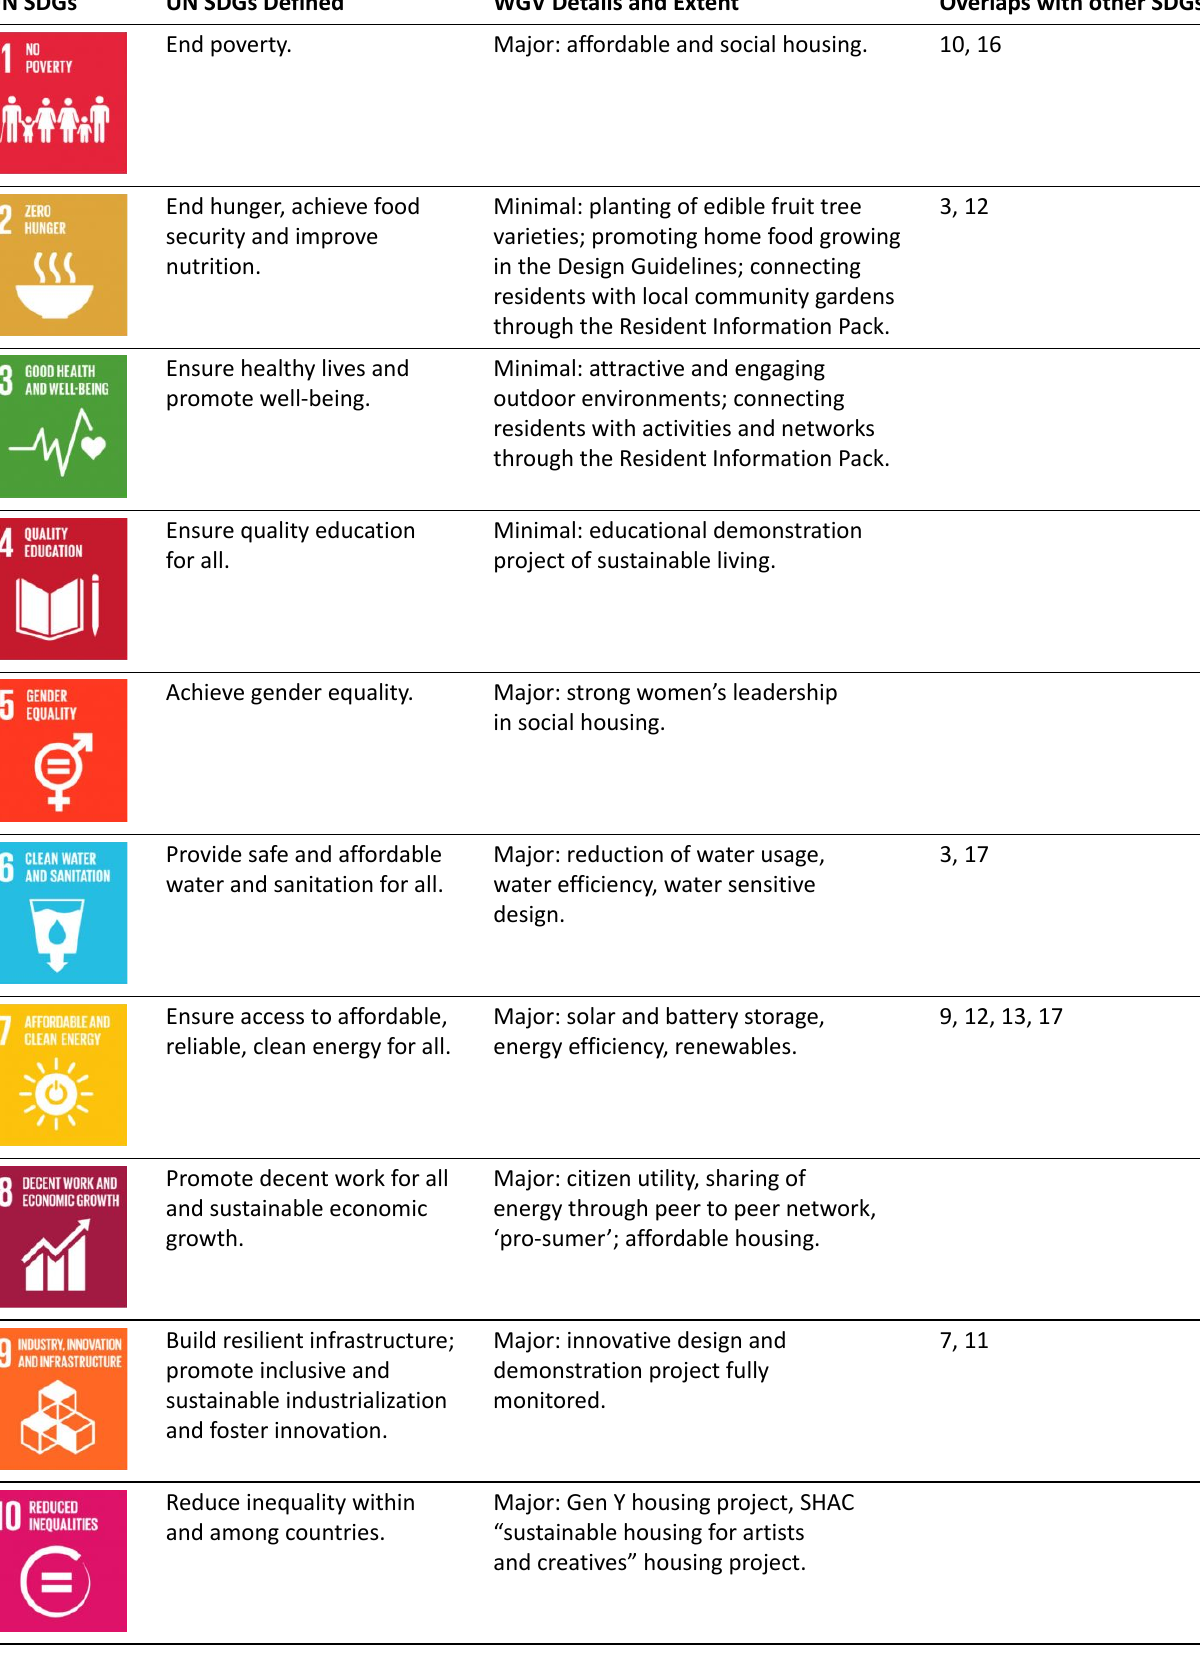
Table 2. SDGs and how the WGV residential development contributes to their